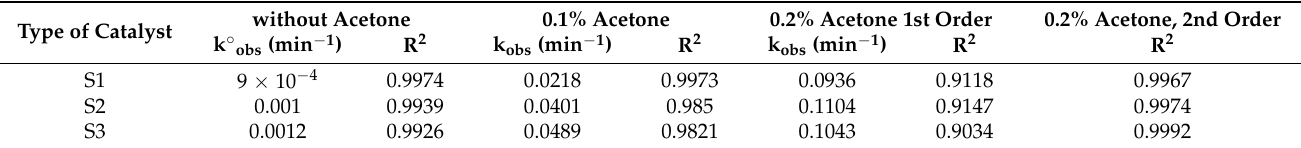
Table 3. k obs values and regression coefficients for describing the photocatalytic kinetics.